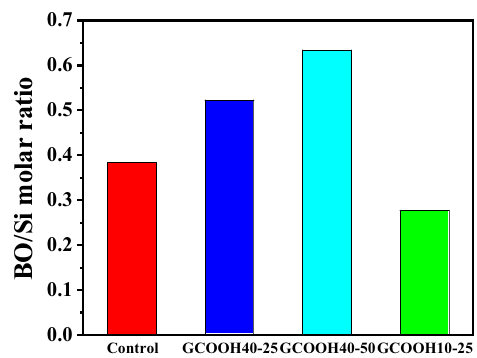
Figure 4: Final bridging oxygen atom